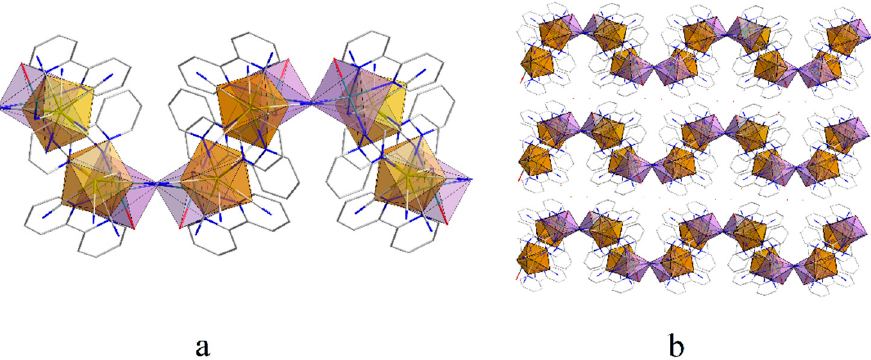
Figure 2. X-ray crystal structure of 3 . ( a ) a fragment of the coordination plane (Miller indices (011)) resulting from cyanido interactions between the tungsten atoms W(IV) and Cd. Yellow and purple are the W and Cd coordination polyhedra, respectively. ( b ) the layered packing. The individual layers are connected by the crystallization water molecules (hydrogen bonds) present in the structure and inter-layer interactions of the π – π type. Hydrogens were omitted for clarity.